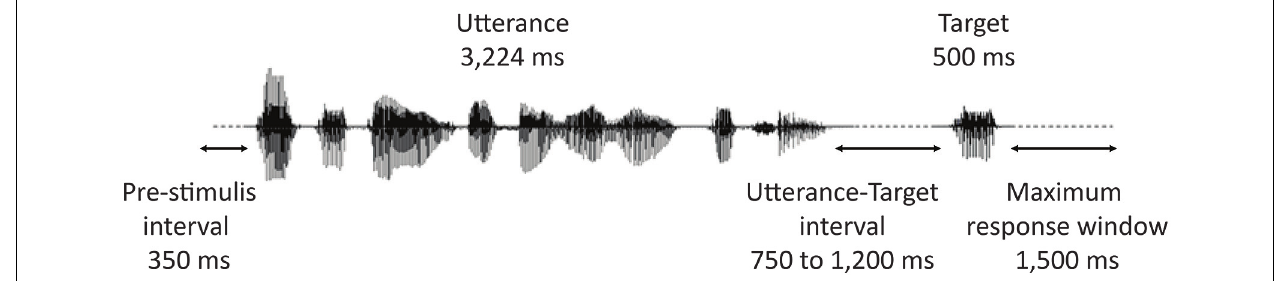
FIGURE 2 |Time-course of a trial.